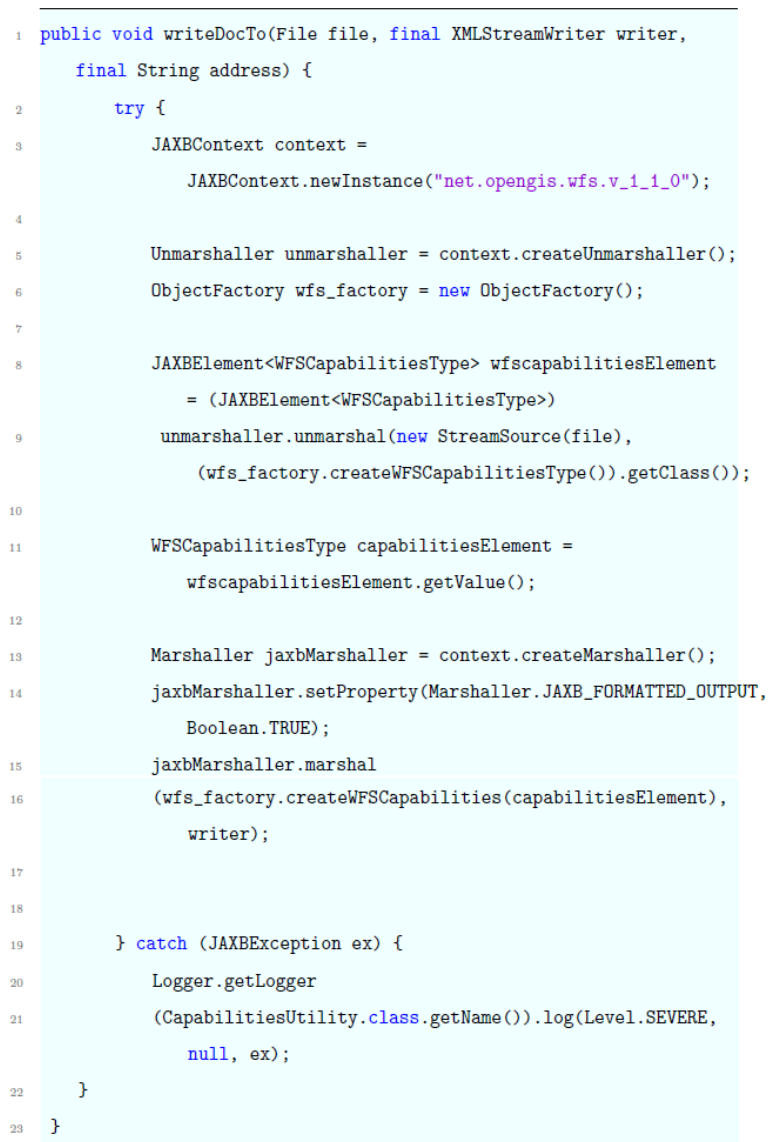
Figure 7. The writeDocTo method.